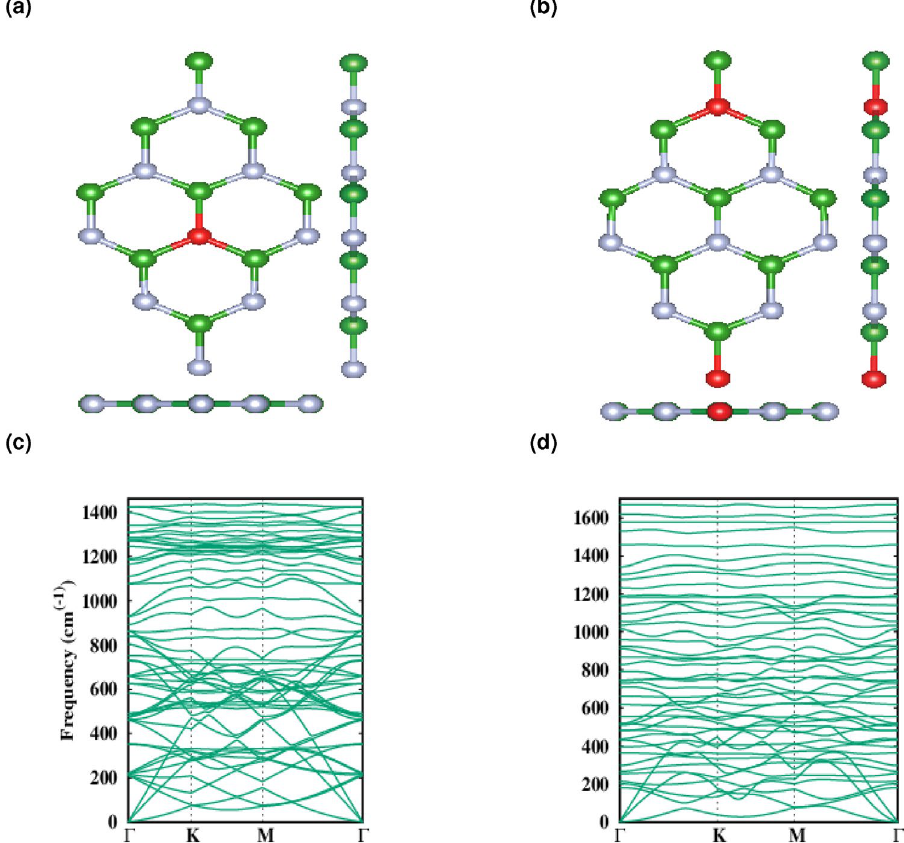
Figure 2. ( a , b ) Top and side views of 5.5 and 11% oxygen doped hBN. ( c , d ) Phonon dispersion for 5.5 and 11% oxygen doped hBN along different high-symmetry paths.